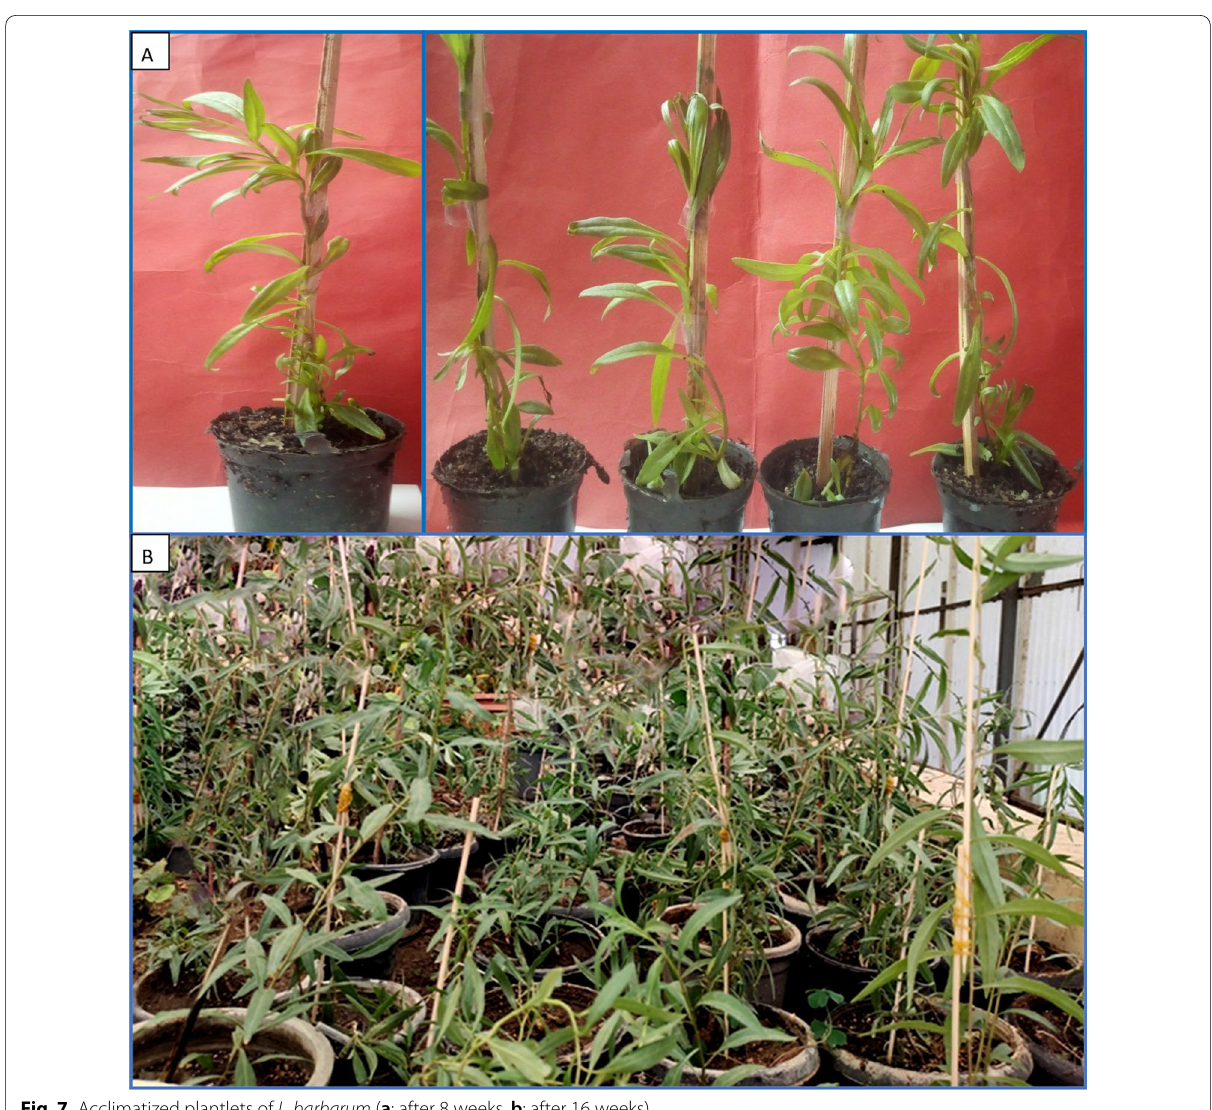
Fig. 7 Acclimatized plantlets of L. barbarum ( a : after 8 weeks. b : after 16